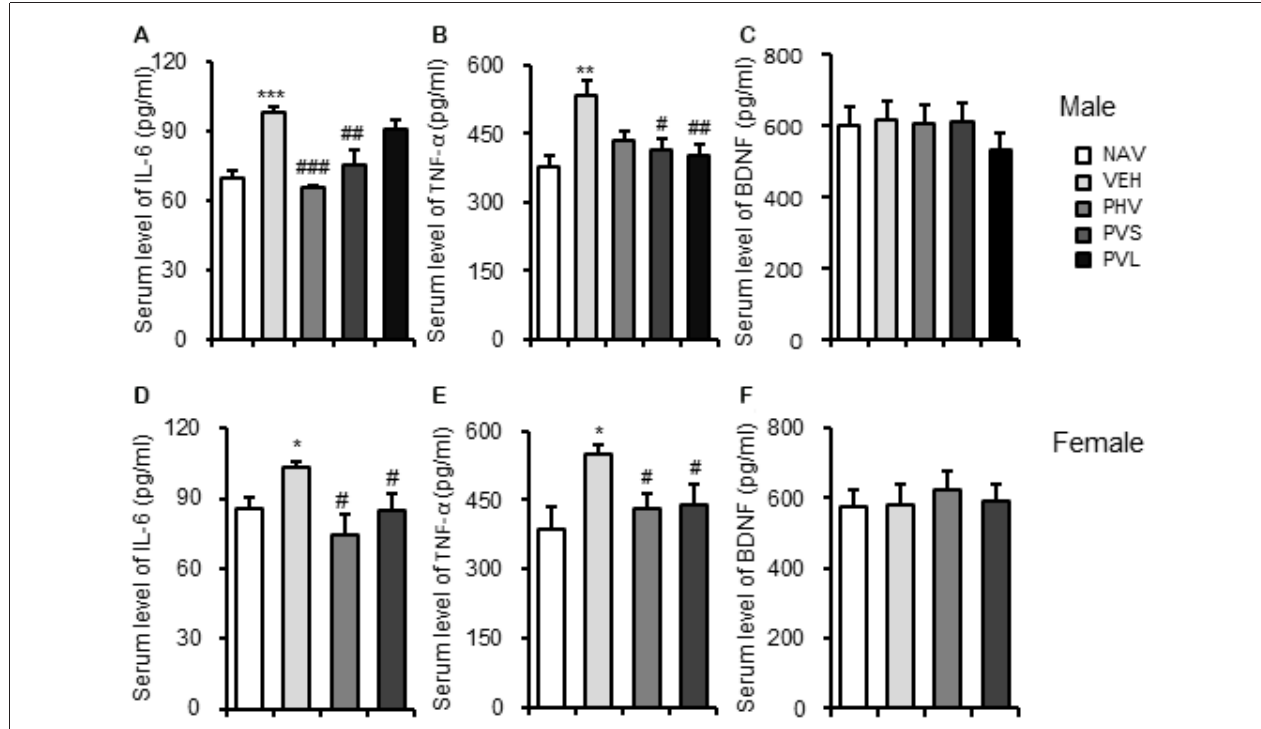
FIGURE 6 | HRW administration blocked the inflammatory response in VPA-exposed mice offspring. ELISA data showed that HRW administration significantly reversed the increased serum levels of interleukin 6 (IL-6; A,D ) and tumor necrosis factor- α (TNF- α ) (B,E) , but not BDNF (C,F) of both male and female mice offspring. ∗ P < 0.05, ∗∗ P < 0.01, ∗∗∗ P < 0.005 compared with the saline-injected group (NAV); # P < 0.05, ## P < 0.01, ### P < 0.005 compared with